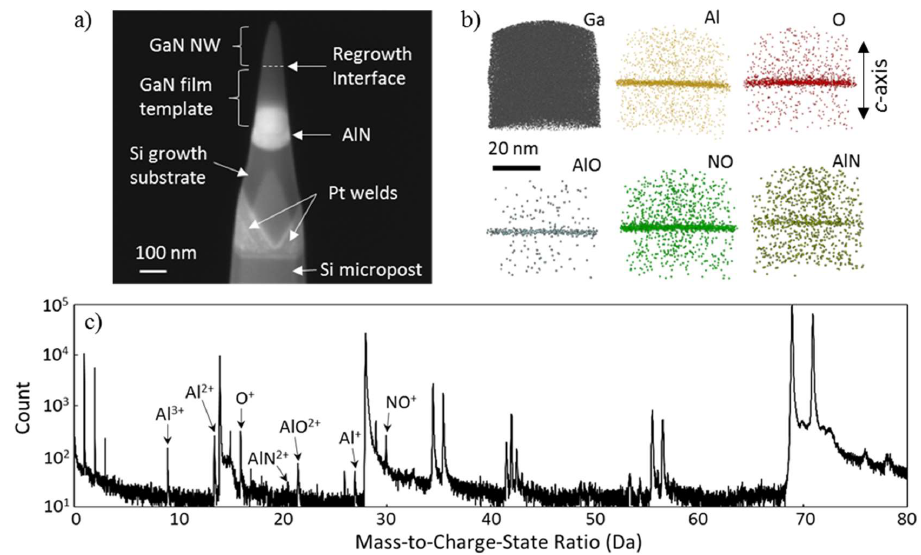
Figure 2. ( a ) FESEM image of L-APT nanowire regrowth interface sample from growth run S1 after FIB lift-out and annular milling; ( b ) Reconstructed positions of L-APT detector hits from mass spectrum peaks hypothesized to be due to Al, O, and related molecular species in the S1 sample. The reconstruction is limited to a region of interest (ROI) near the regrowth interface. The reconstructed positions of likely Ga atoms are also shown for comparison; ( c ) Accumulated mass spectrum histogram from the ROI (including background signal), showing the peaks hypothesized to be related to Al and O.